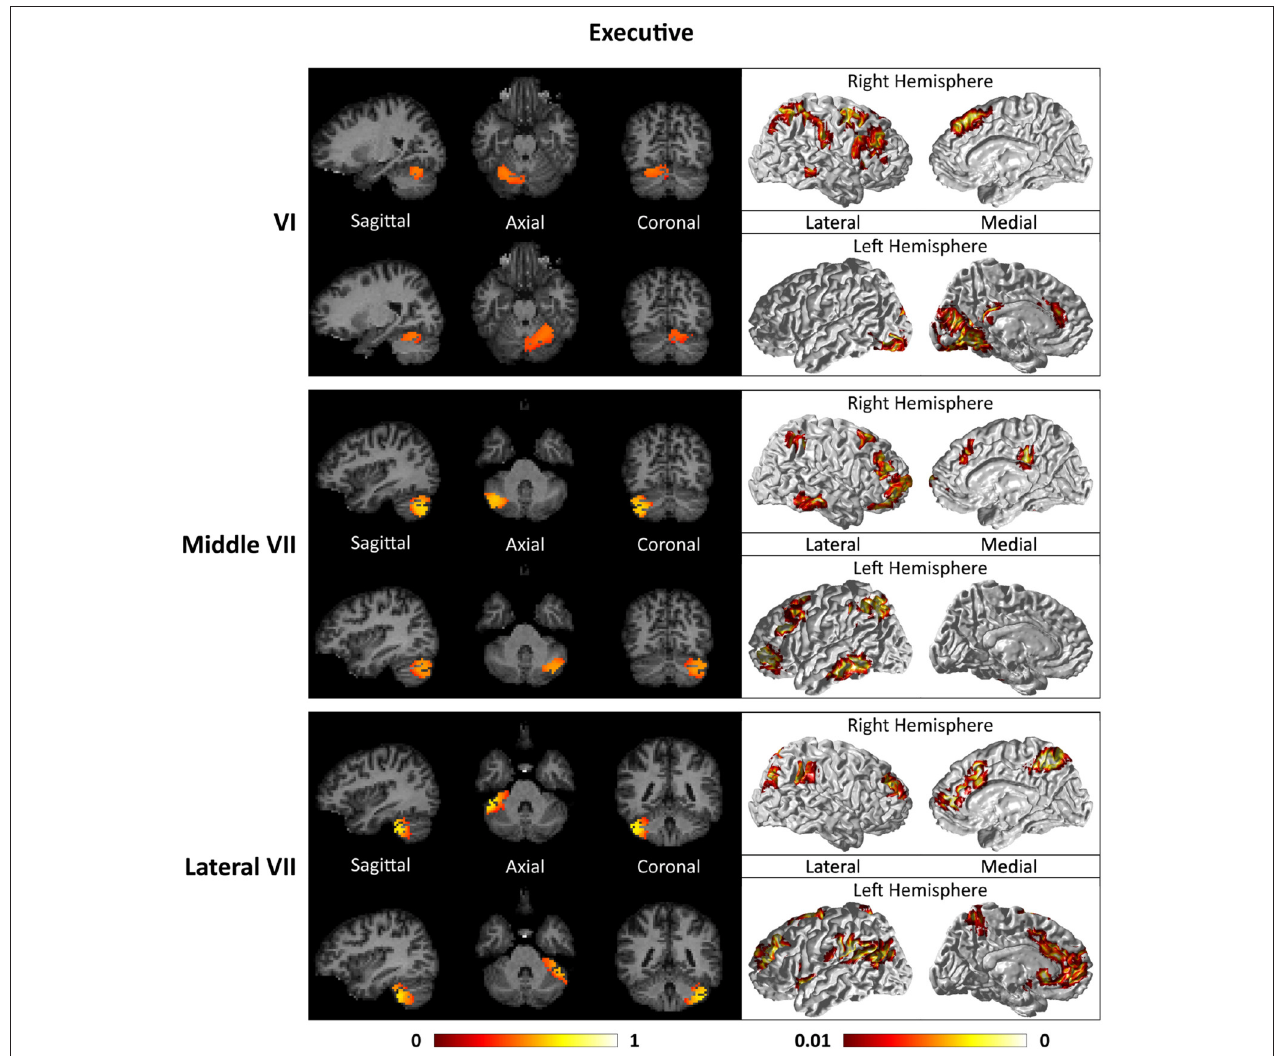
FIGURE 9 | Cerebellar clusters (left column) that correspond to lobules middle VII (first row) and lateral VII (second row) are found to be functionally connected to subnetworks of executive control and salience systems (right column).